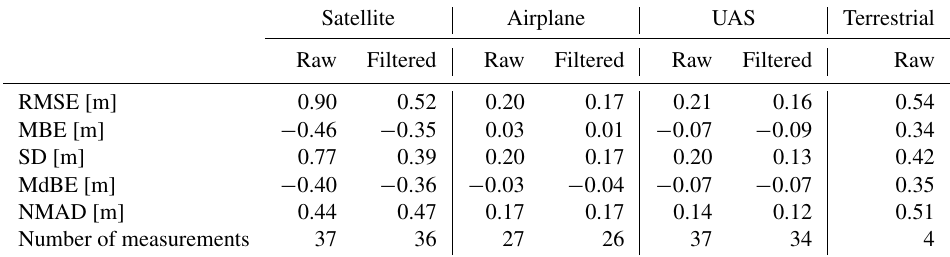
Table 4. A summary of the accuracy assessment of snow depth maps compared to the manual and snow pole measurements for the satellite, airplane, UAS and terrestrial imagery (comparison 1). For the satellite, airplane and the UAS, the threshold of plus or minus 2 SDs was applied, and the updated values are depicted in the column “Filtered”. Satellite Airplane UAS Terrestrial Raw